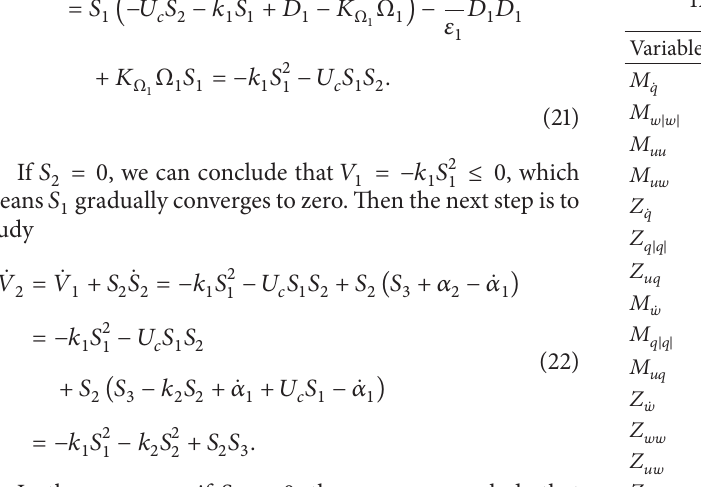
Table 1: Hydrodynamic parameters of REMUS AUV.